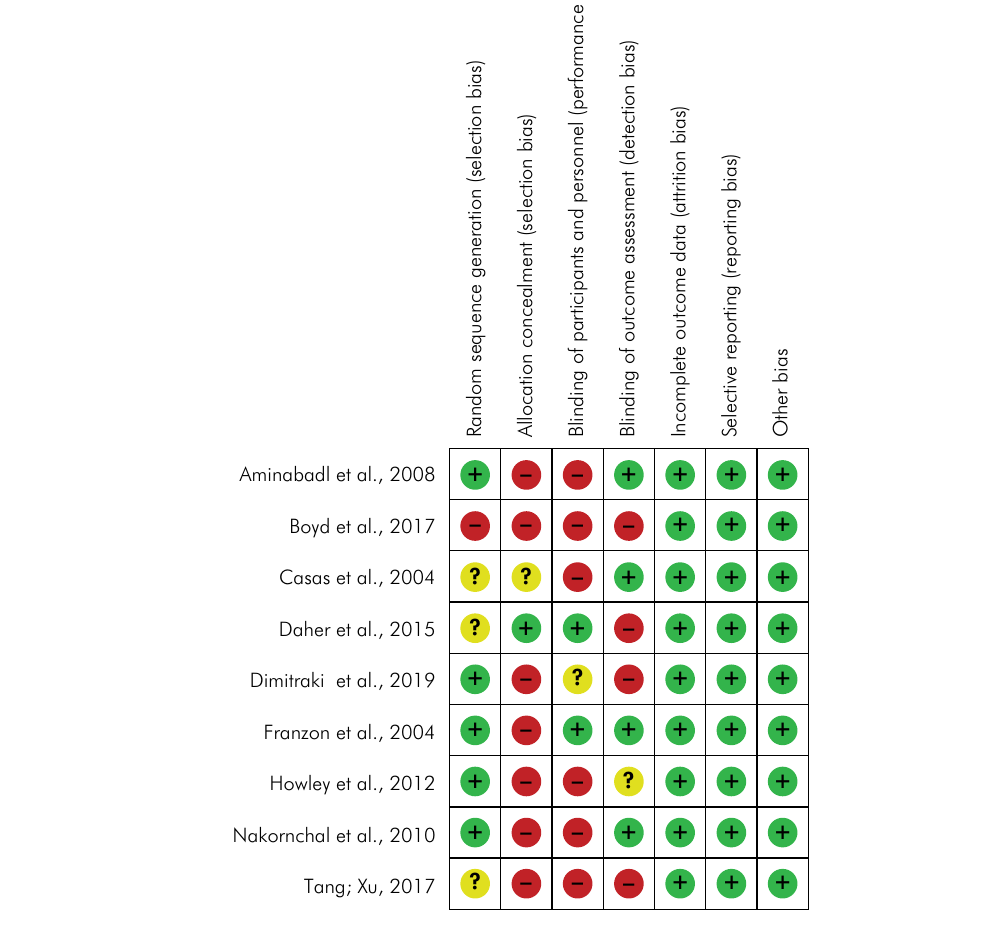
Figure 2. Risk of bias assessment according to the evaluated